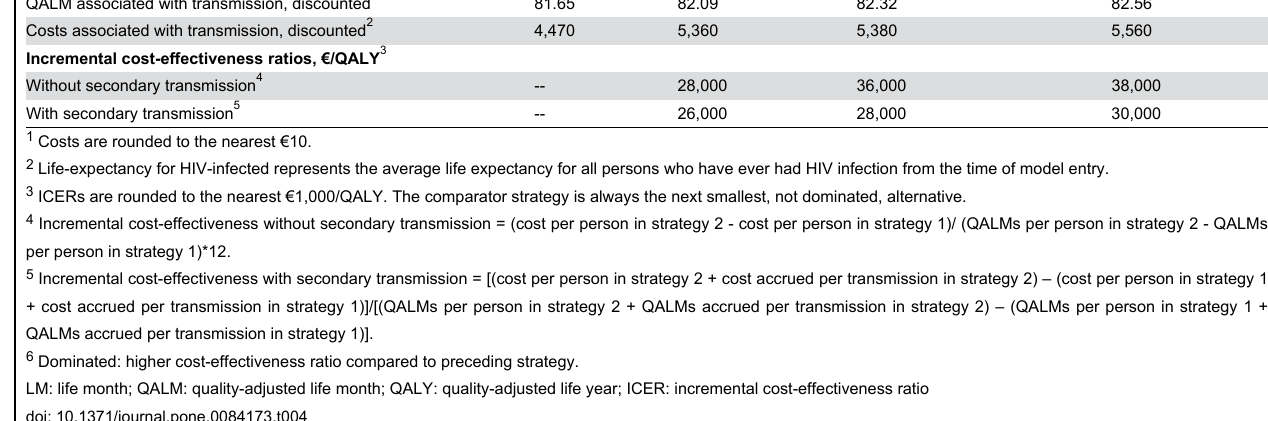
Variable Annual